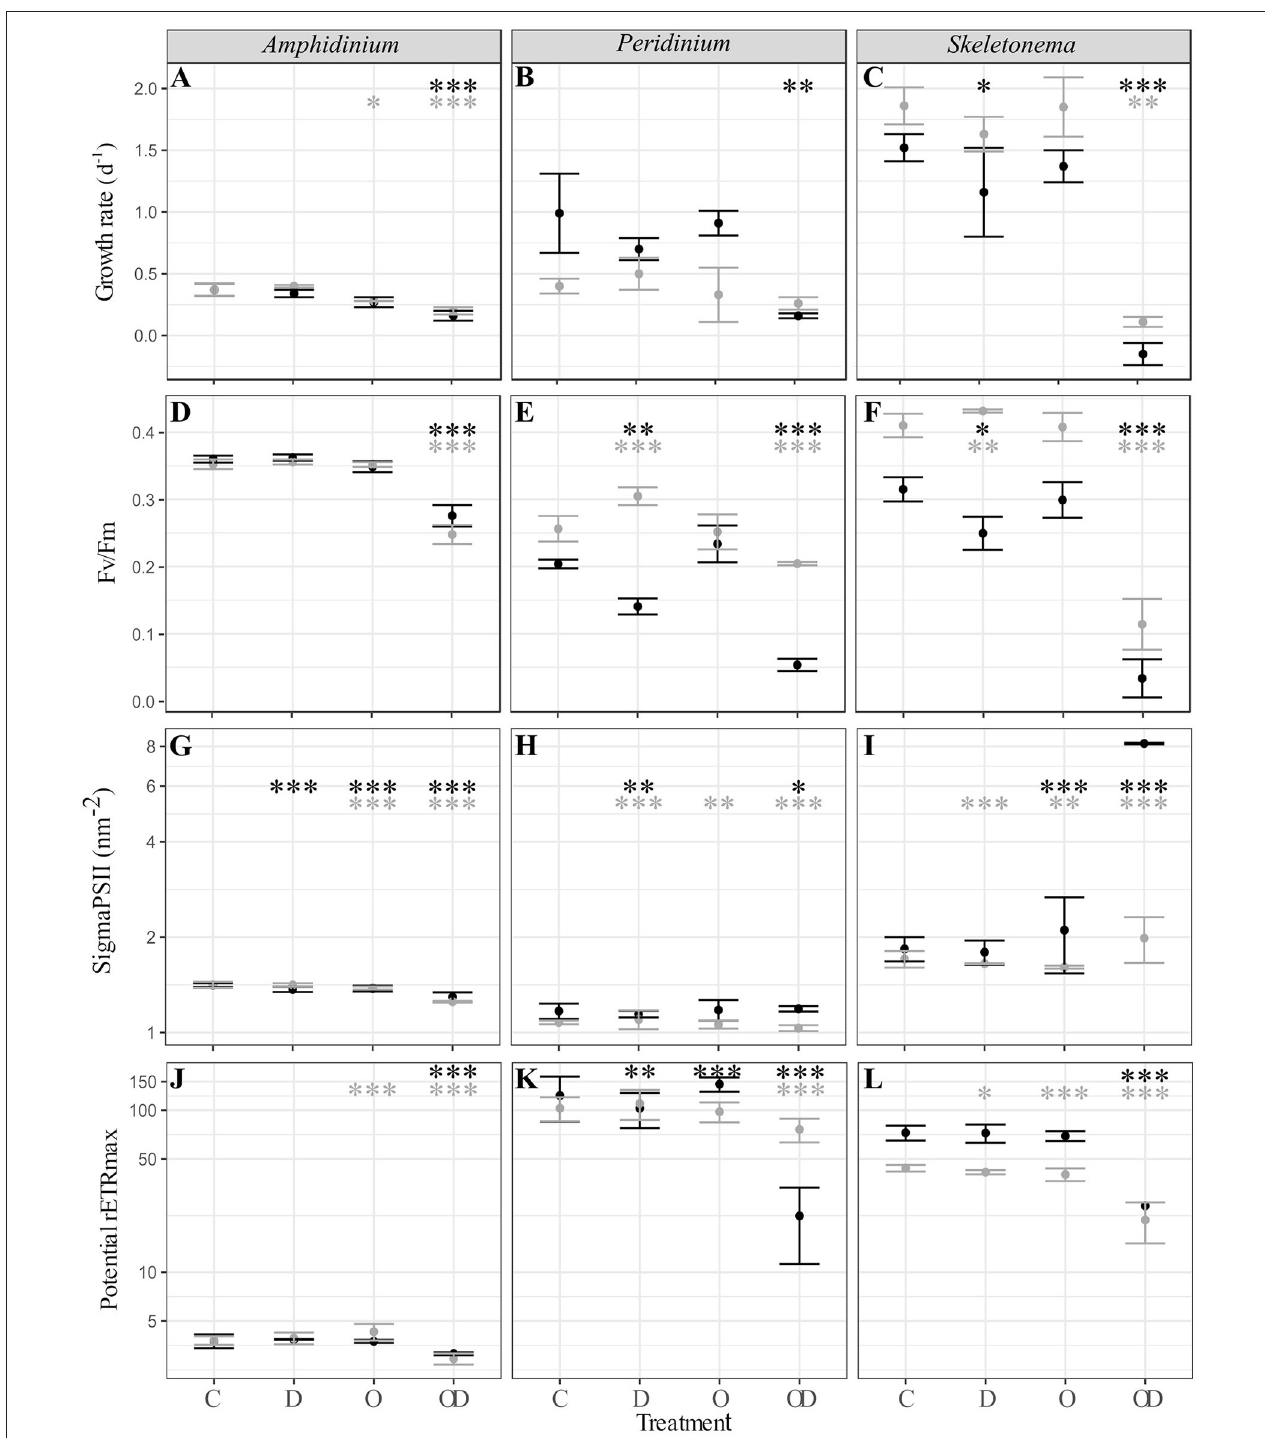
FIGURE 1 | (A–C) Phytoplankton growth rate (d − 1 ); (D–F) photosynthesis efficiency (Fv/Fm, dimensionless); (G–I) PSII cross section (sigmaPSII, nm − 2 ); and (J–L) potential maximal relative electron transport rate (potential rETRmax, dimensionless) of xenic (black) and axenic (gray) cultures of (A,D,G,J) A. carterae ; (B,E,H,K) P. sociale ; and (C,F,I,L) Skeletonema sp. Treatments are C for control, D for dispersant alone, O for crude oil, OD for dispersed crude oil. The photosynthetic parameters were averaged over time and the error bars represent the standard deviation between the triplicates. Stars represent the significant Dunnett’s test p -values (ANOVA post-hoc tests) comparing the control to the other treatments for the xenic (black) and axenic (gray) cultures. * p < 0.05; ** p < 0.01; *** p < 0.001. P -values resulting from pairwise students tests between X and AX physiological parameters for each culture are in Table S1 .